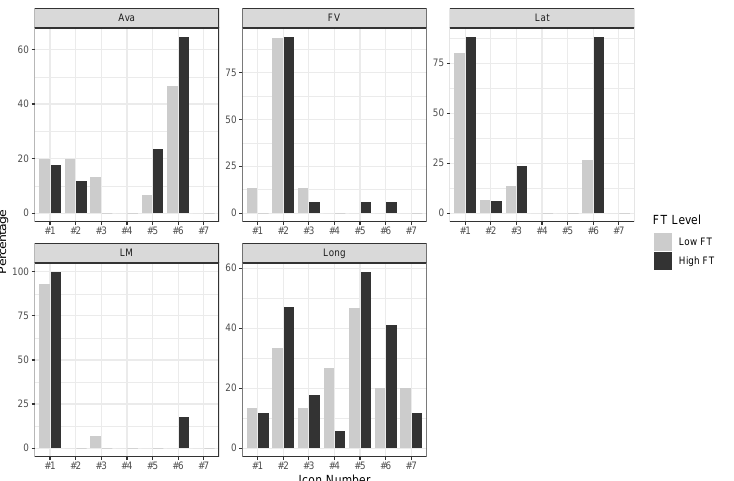
Figure 10. Percentages of Tesla HMI icons used to answer TRASS questions from participants with high and low FT.